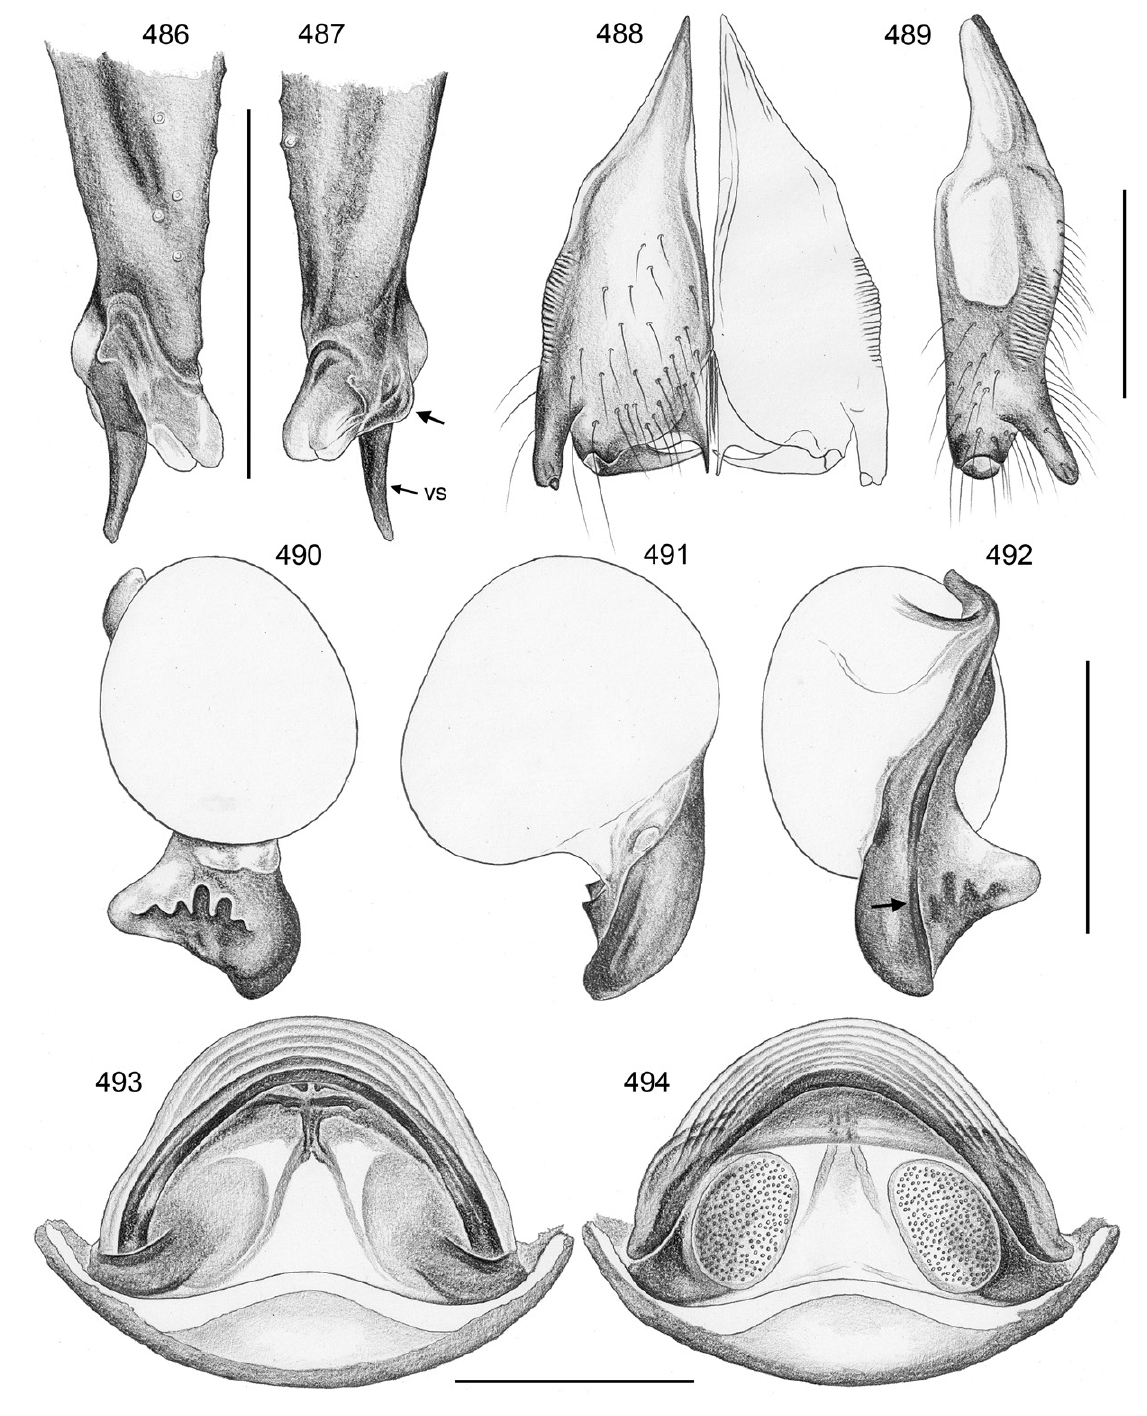
Figs 486–494. Crossopriza moqal sp. nov.; male and female from Oman, Moqal Cave (ZFMK Ar 22421, Ar 22422). 486–487 . Left procursus, prolateral and retrolateral views; arrow: distinctive ventral hump. 488–489 . Male chelicerae, frontal and lateral views. 490–492 . Left genital bulb, prolateral, dorsal, and retrolateral views; arrow: retrolateral ridge. 493–494 . Cleared female genitalia, ventral and dorsal views. Abbreviation: vs = ventral sclerite. Scale bars = 0.3